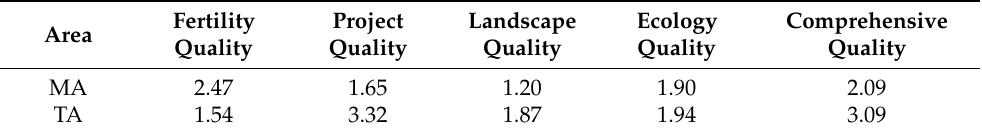
Table 5. The average CLQ in MA and TA.